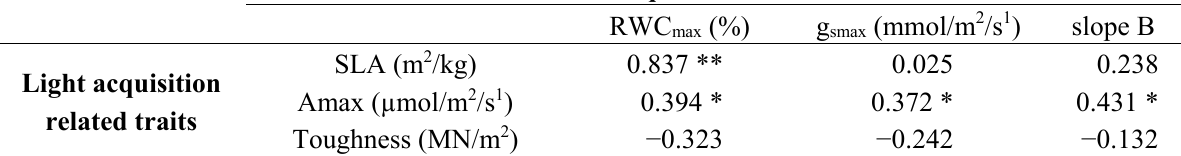
Table 1. Correlations (Spearman’s rho) between light acquisition related traits (left column: SLA, specific leaf area; A max , maximum photosynthetic rate; and leaf toughness) and water acquisition related traits (upper row: RWC max , maximum relative water content; g smax , maximum stomatal conductance at full hydration; slope B, slope of the drought response curve). *: p < 0.05; **: p < 0.01.